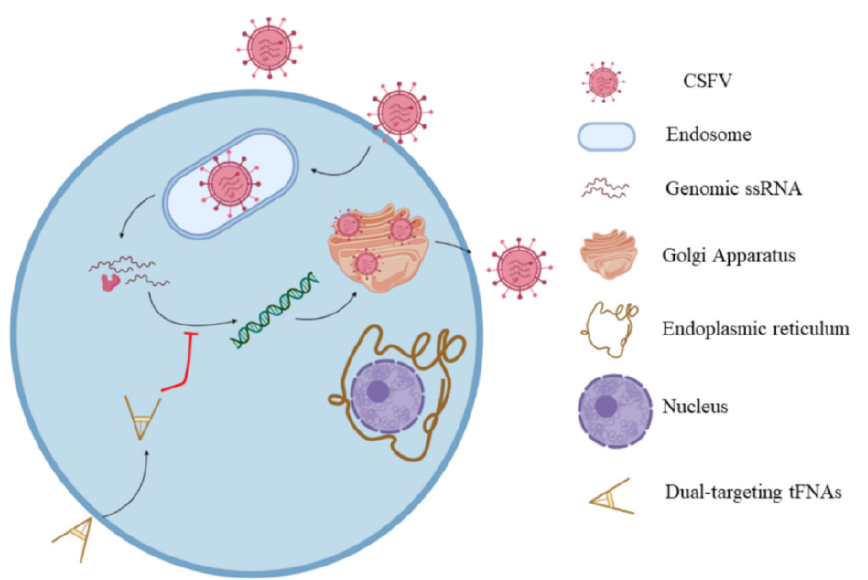
Figure 9. Schematic illustration of the mechanism of siRNA delivery by tFNA nanomaterial. Reprinted with permission from Ref. [134]. Copyright 2021, American Chemical Society.